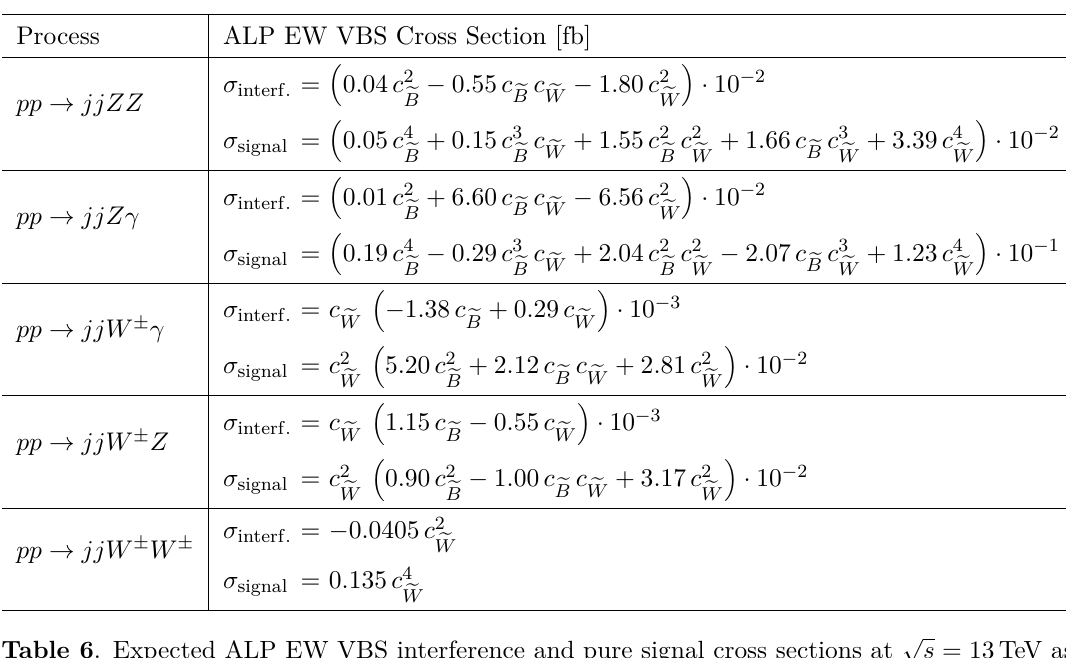
and c for f a = 1 TeV after selection cuts and requiring e W e B